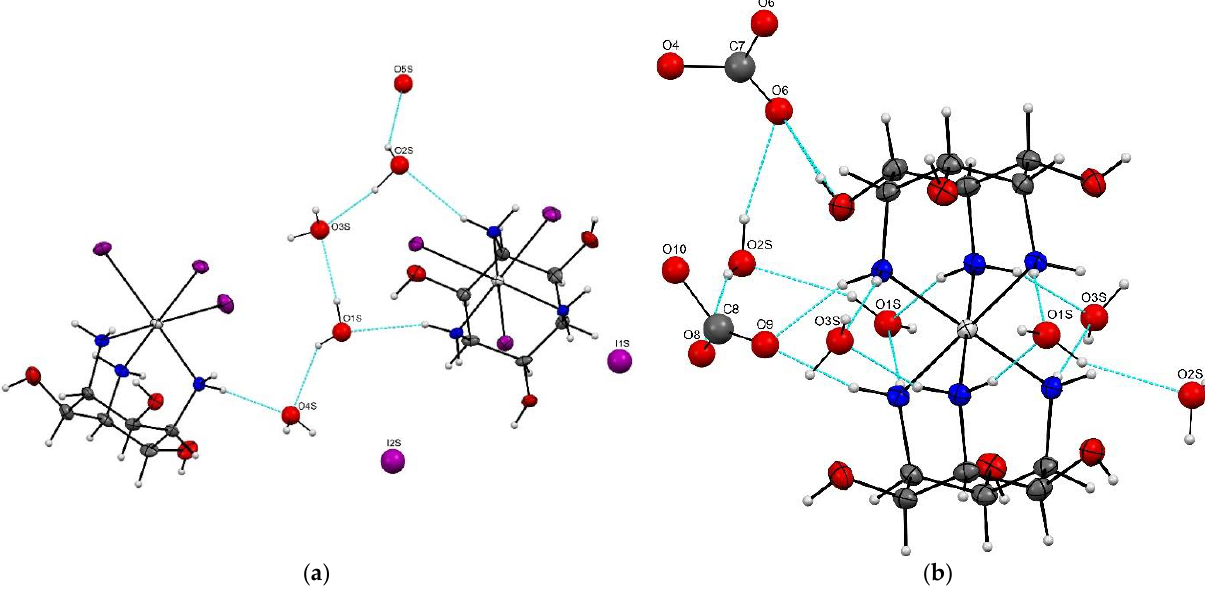
Figure 2. H-bond networks in the crystal structures of 1A ( a ) and 2A ( b ). The solvent and carbonate atoms are presented as balls for clarity. atoms are presented as balls for